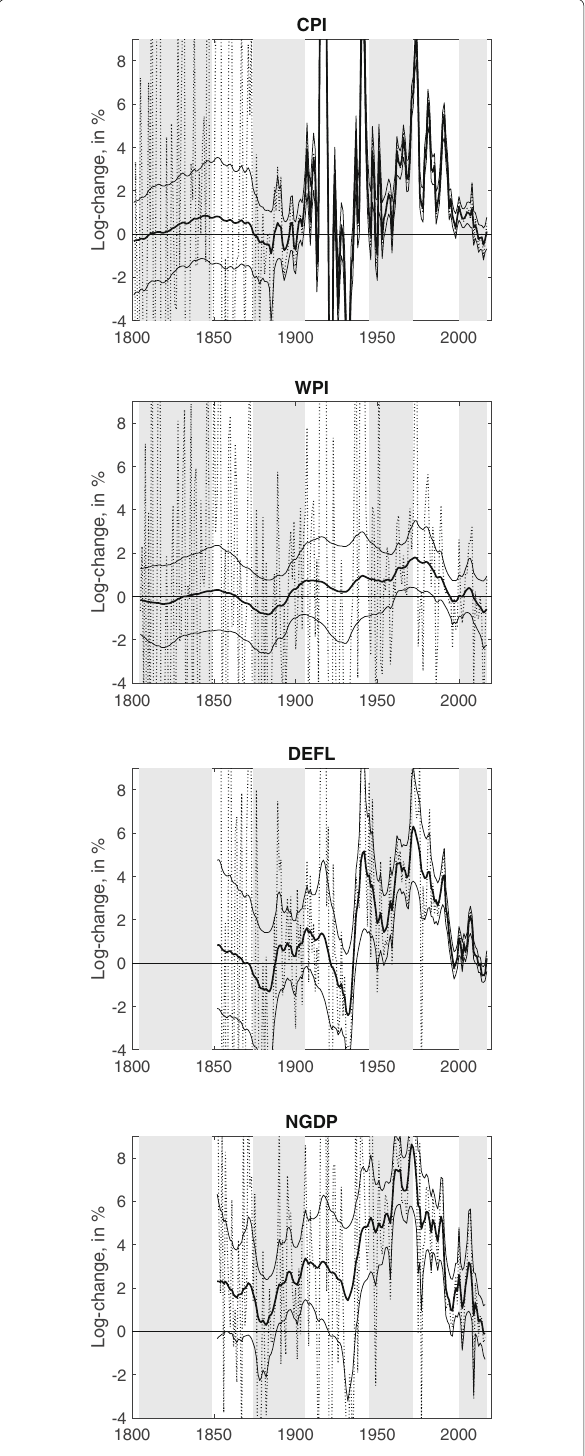
Fig. 7 Permanent component (UC-SV model). UC-SV model without MA component by Stock and Watson (2007). Estimated permanent component (mean, 5th percentile, 95th percentile) and actual data (dashed line). The shaded and unshaded areas represent various monetary